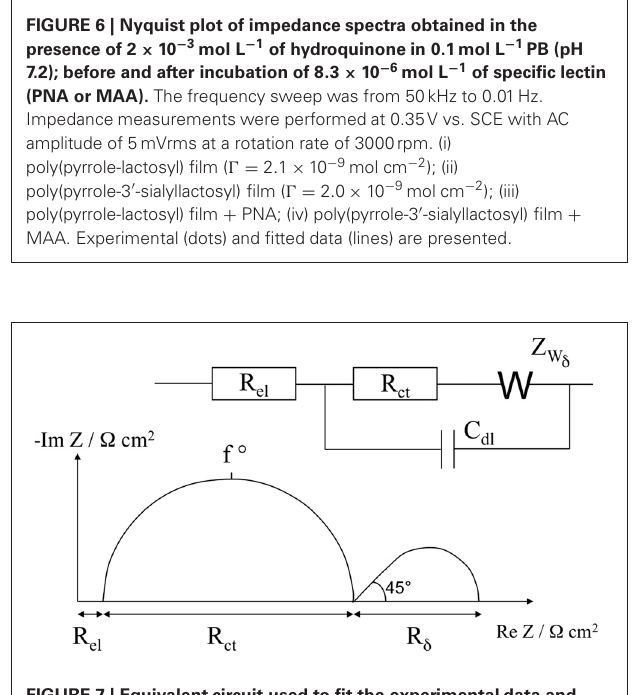
FIGURE 7 | Equivalent circuit used to fit the experimental data and schematic representation of Nyquist plot corresponding to this equivalent